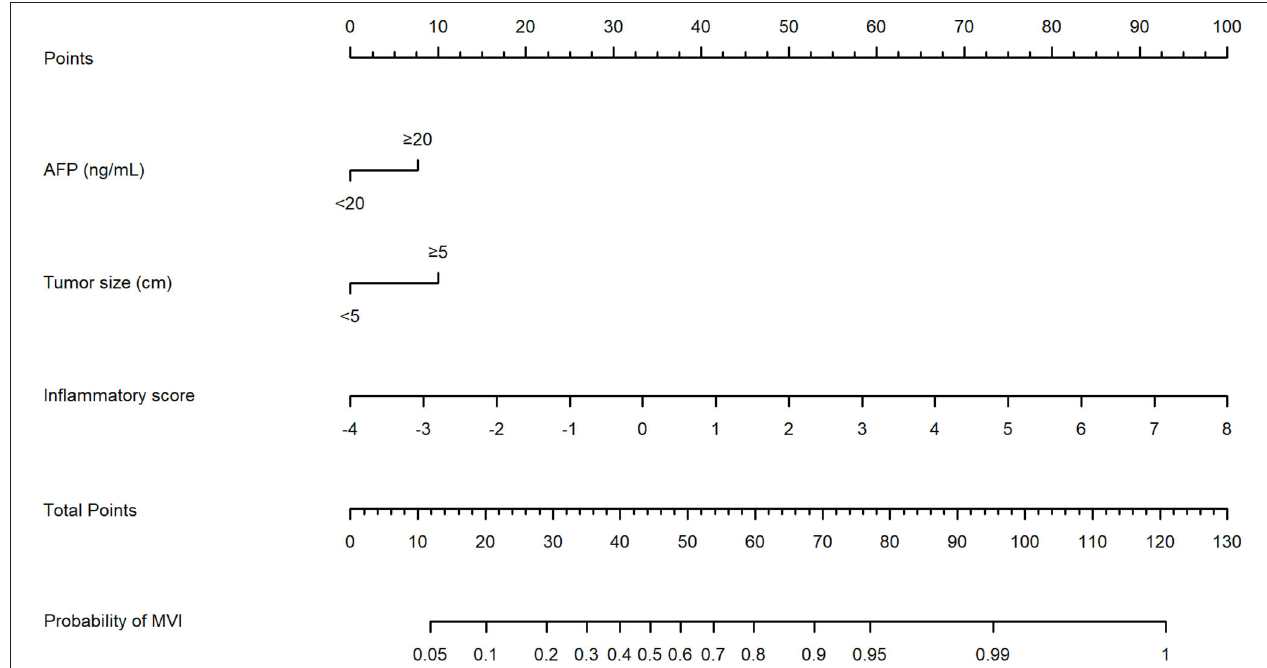
FIGURE 2 | The nomogram model established by incorporating the alpha fetoprotein (AFP), tumor size, and inflammatory score to predict the risk of microvascular invasion (MVI) for patients with hepatocellular carcinoma (HCC).